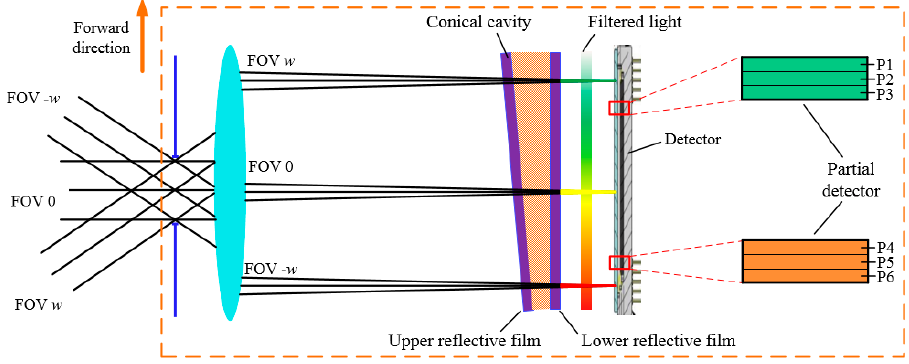
Figure 1. Schematic diagram of filter splitting.